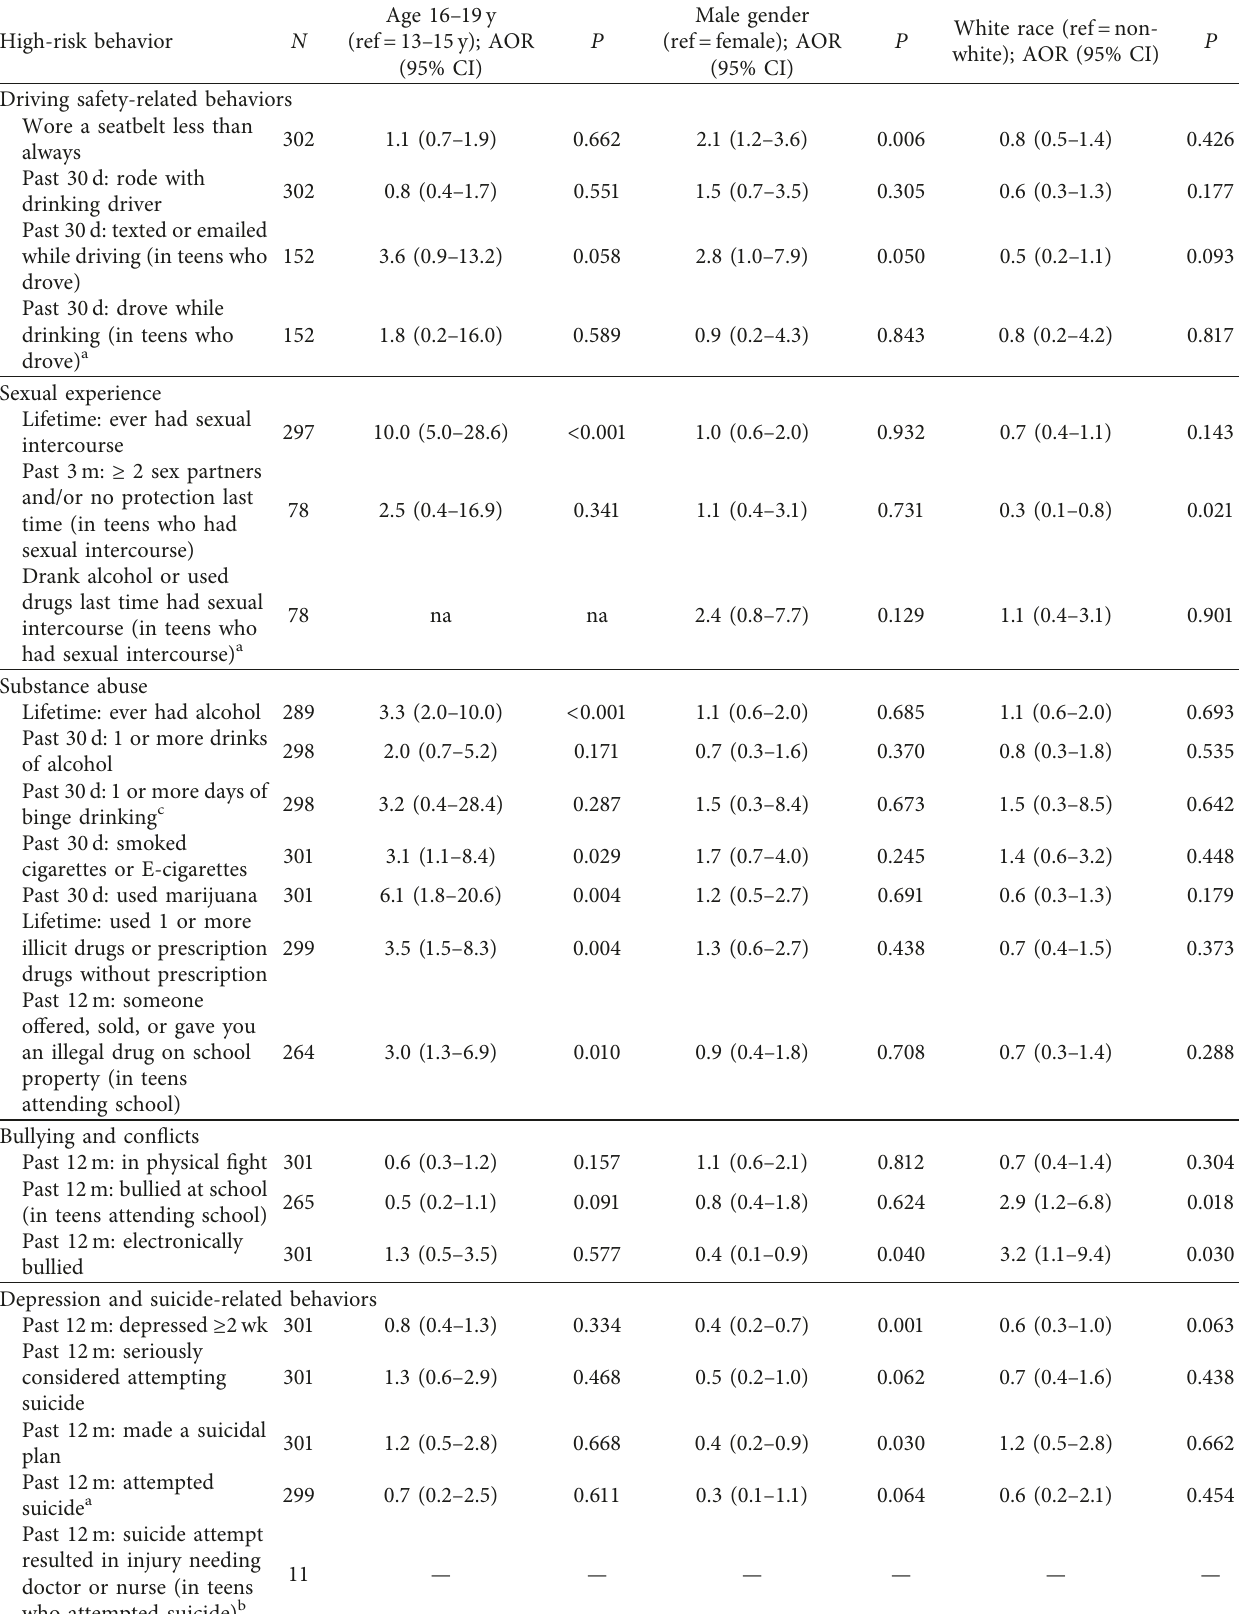
a Oddsratiosareunadjustedbecausethenumberofteenswhohadthebehaviorwastoosmallforlogistic regression. b Statisticswerenotperformedbecause the sample size is too small;4/11 (36.4%) teens who attempted suicide required medical attention. c Bingedrinking is defined as having 5 ormore drinks of alcohol in a row, within a couple of hours. AOR, adjusted odds ratio; CI, confidence interval; d, days; m, months; Ref., reference category; wk, weeks; y, years. Multiple logistic regression models included age category, gender, race, type of kidney disease, and number of medications/day. na, odds ratio not available because no 13- to 15-year-olds drank or used drugs the last time had